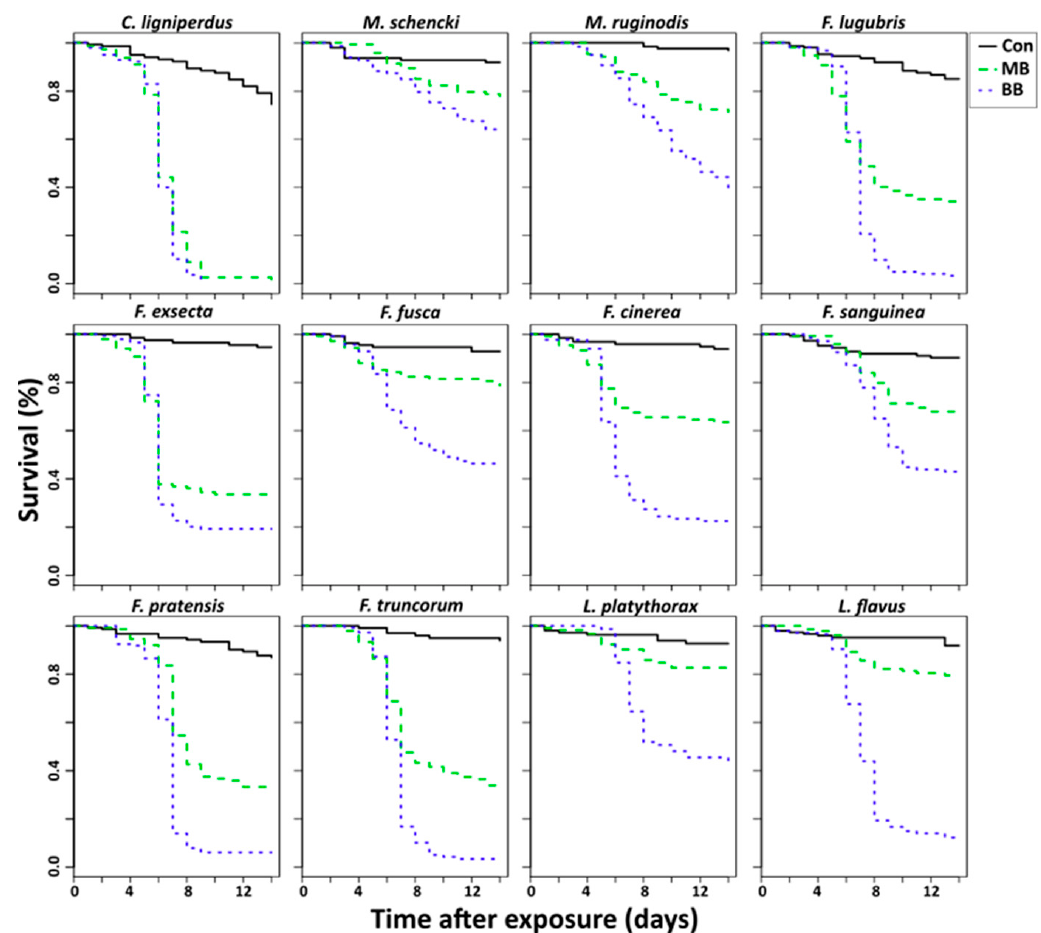
Figure 1. Survival comparisons between control ants (Con), ants exposed to B. bassiana (BB), and ants exposed to M. brunneum (MB).